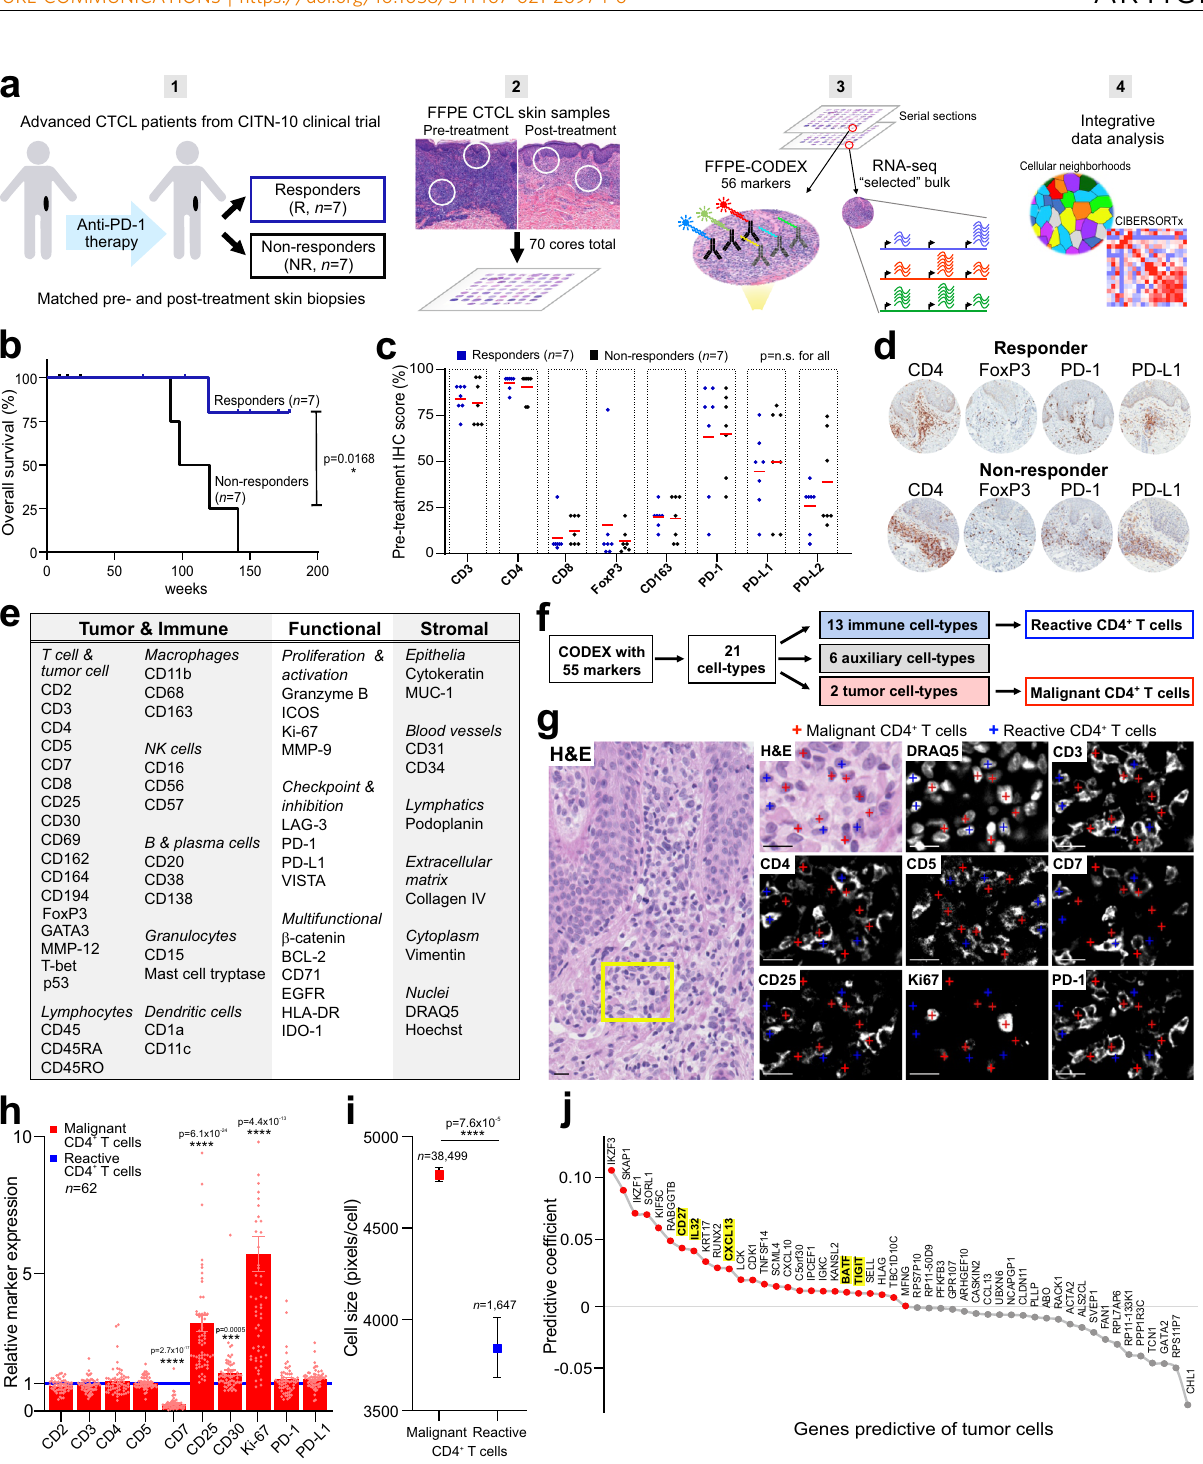
reactive CD4 + T cells (blue crosses) and malignant CD4 + T cells (red crosses) showed that in tumor cells CD7 was decreased and CD25 and Ki-67 were increased (Fig. 1g), consistent with an advanced CTCL phenotype 26 . Quantifying these expression dif- ferences for tumor cells relative to reactive CD4 + T cells revealed fold-changes of 0.26 for CD7, 1.40 for CD30, 3.20 for CD25, and 5.73 for Ki-67 (Fig. 1h). Tumor cells were also larger than reactive CD4 + T cells (Fig. 1i), in line with the previous reports 27 . While one patient ’ s tumor cells had large cell transformation, the average size of those tumor cells were not signi fi cantly different from those of the other 13 patients. Additionally, we identi fi ed